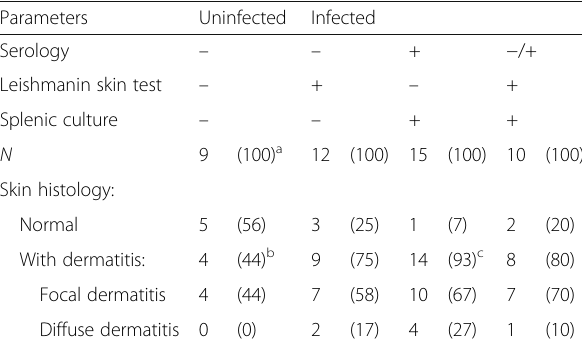
Table 3 Response to L. chagasi infection and frequency of dermatitis in stray dogs from an endemic area of visceral leishmaniasis